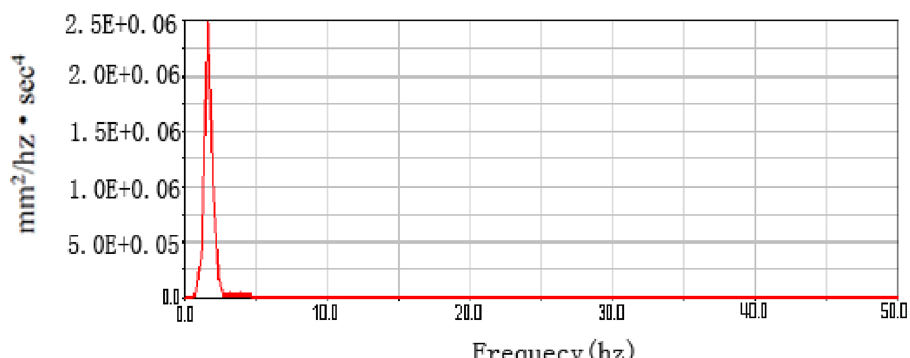
Fig. 13 Test 8. Acceleration Response